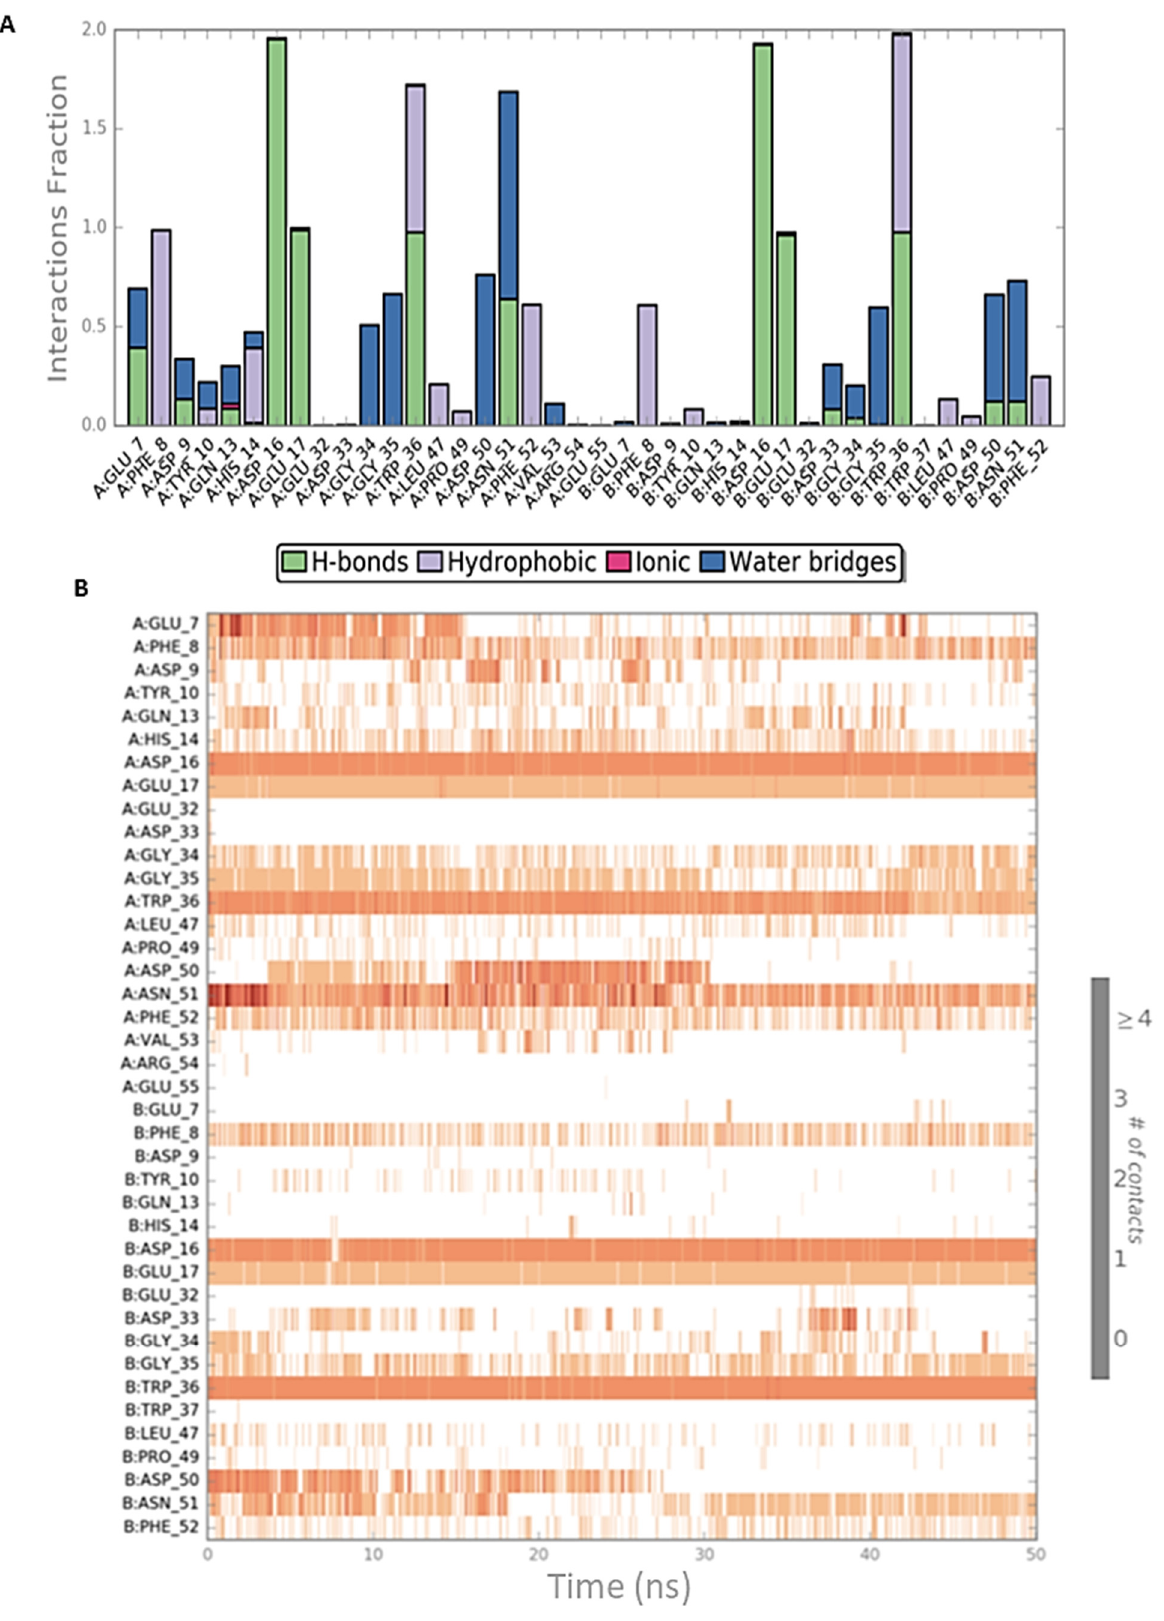
Figure 4. Schematic representations of the interactions occurring in the second MD simulation of CIN85-Cbl-b complex from PDB 2BZ8. ( A ) Histogram plot highlighting the CIN85 residues involving in the interactions with Cbl-b. ( B ) Timeline representations of the interactions during the MD simulation.